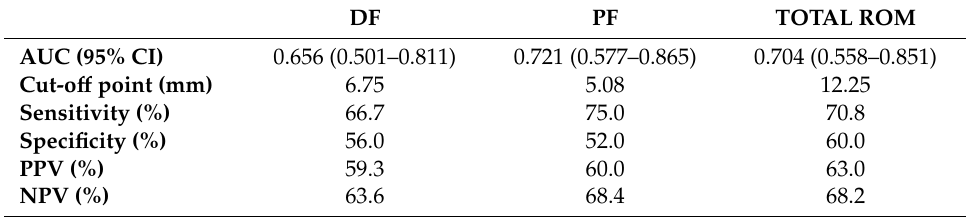
Table 6. Area under curve (AUC), sensitivity, specificity, positive predictive value (PPV) and negative predictive value (NPV) of the new device measurements. DF: Dorsiflexion; PF: Plantarflexion; ROM: Range of